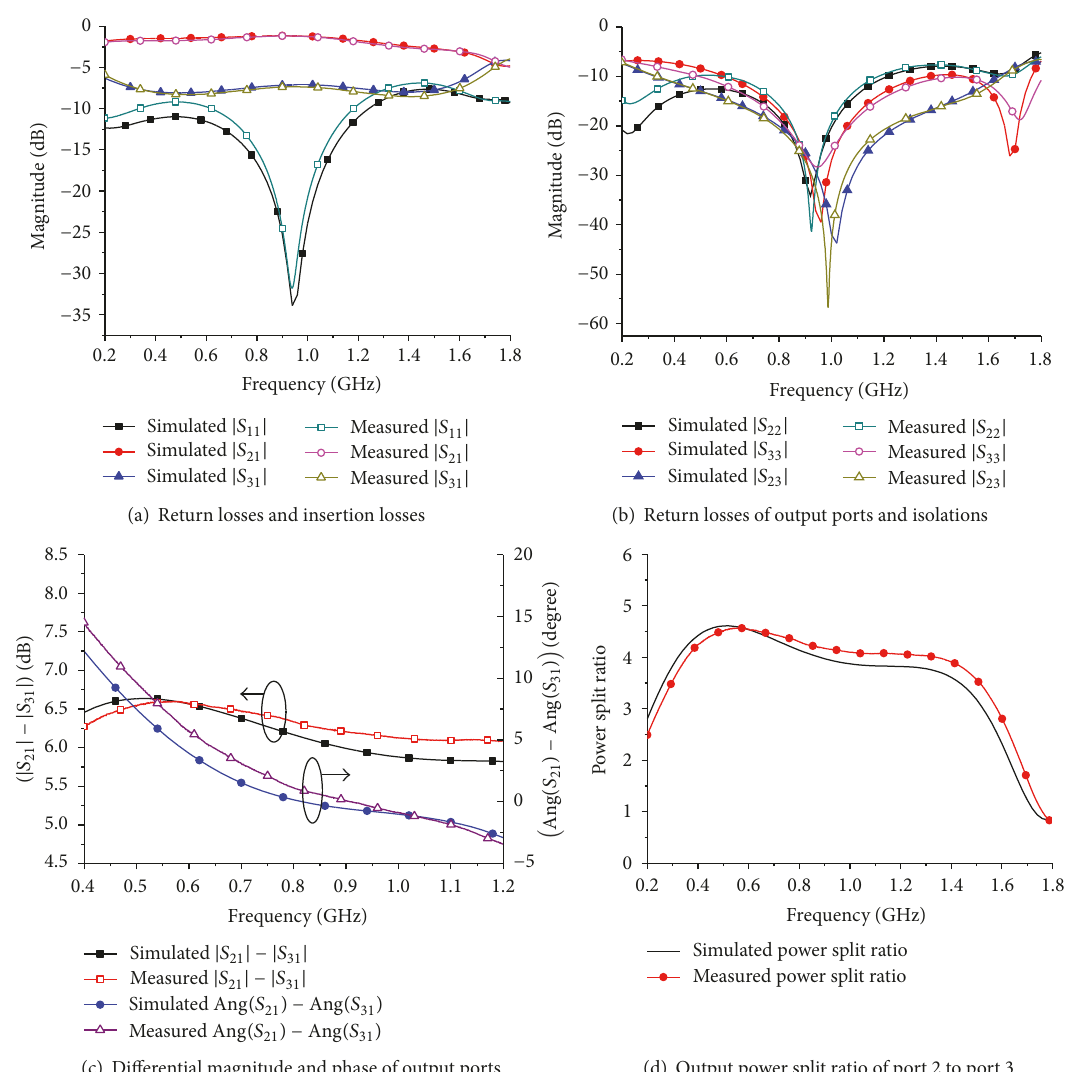
Figure 11: Simulated and measured results of 4: 1 unequal power